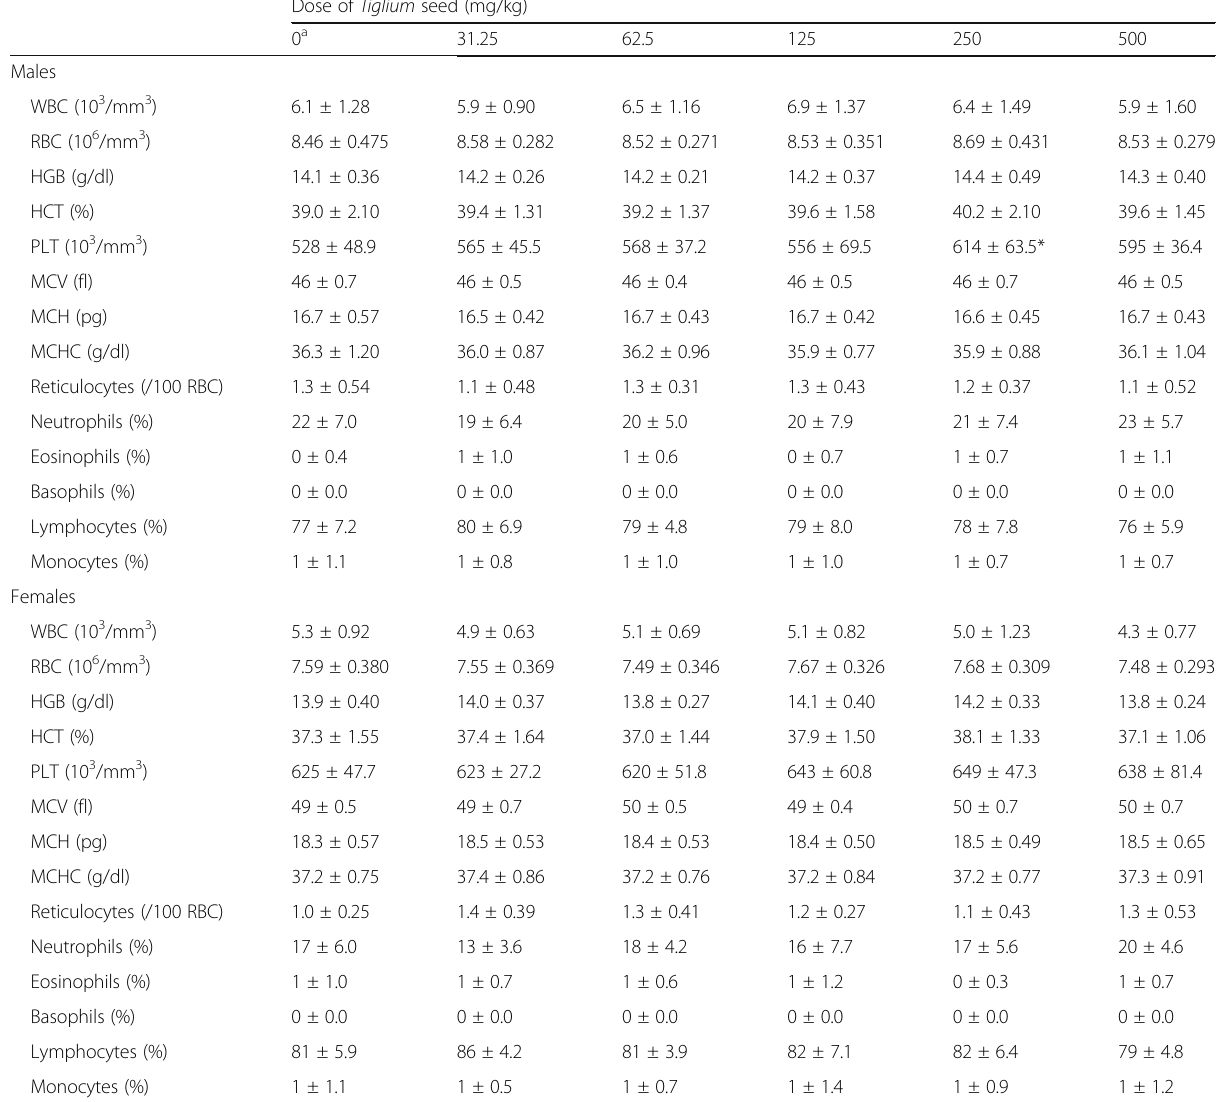
Table 1 Hematological data of male and female F344 rats orally administered with Tiglium seed extract for 13 weeks Dose of Tiglium seed